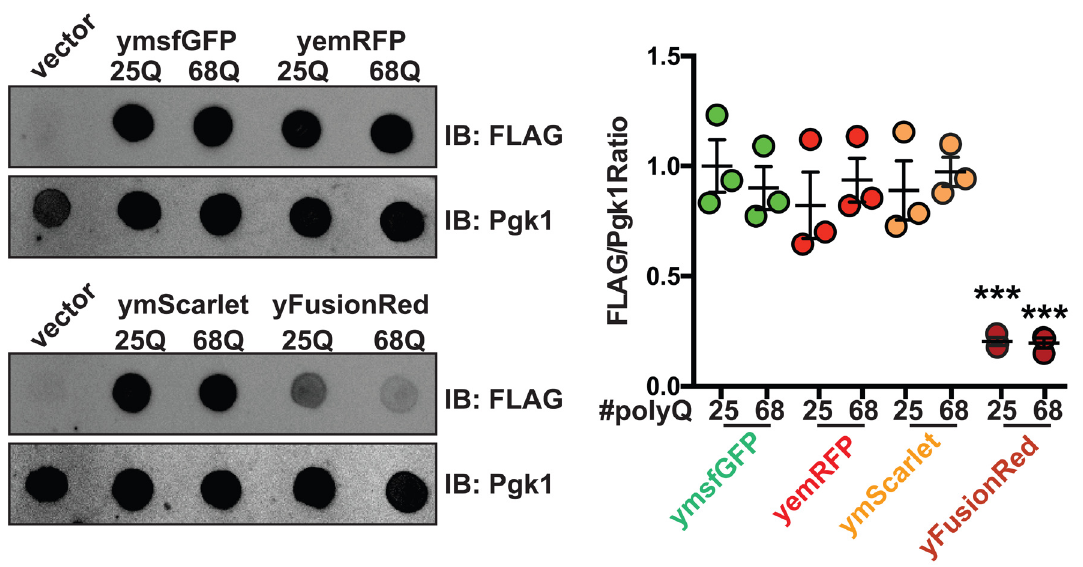
Figure 3. yFusionRed-tagged Htt ex1 fusions are expressed at lower levels compared to other fluorescent fusions. ( A ) Yeast cells carrying an empty vector or 25/68Q Htt ex1 fused to ymsfGFP, yemRFP, yFusionRed or ymScarlet or carrying an empty vector were induced overnight in galactose containing media and protein levels analyzed by dot blot using either an anti-FLAG (detection of fluorescent fusions) or anti-Pgk1 antibody (loading control). Quantification of the FLAG/Pgk1 ration is shown from 3 independent experiments. ***p<0.001 according to a one way ANOVA followed by a Tukey’s multiple comparison test comparing samples to ymsfGFP-tagged fusion of the same polyQ